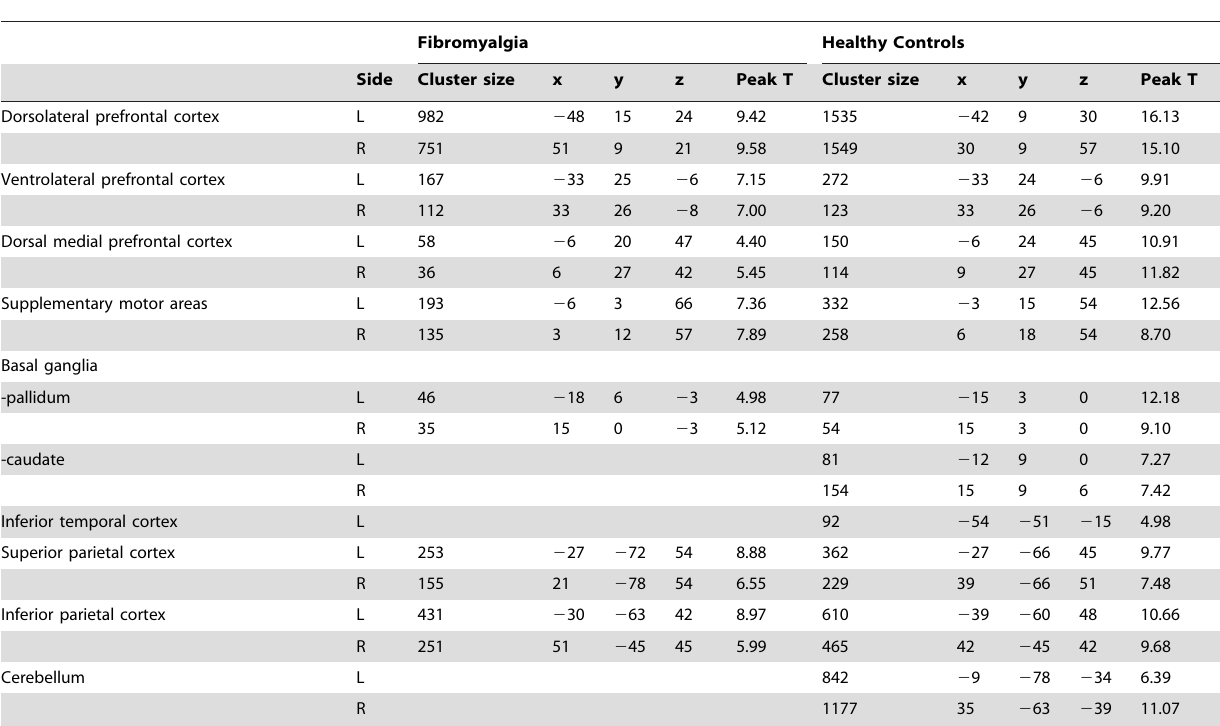
Table 2. 2-back minus 0-back activation one sample t-test (FDR corrected for multiple comparison, P , 0.01 and minimum cluster size of 64).